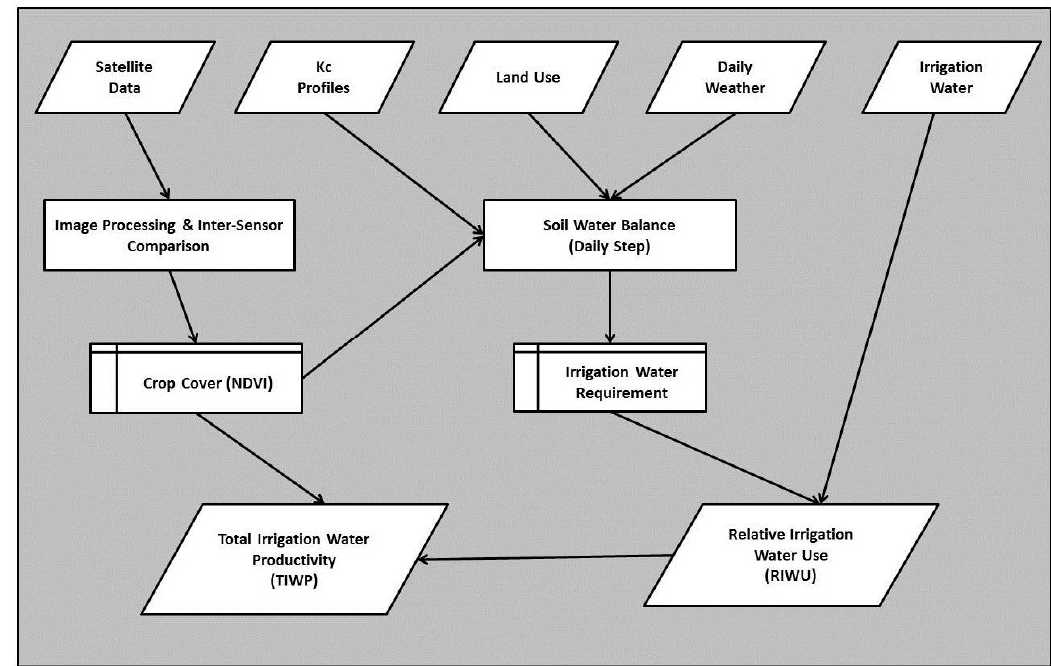
Figure 2. Flowchart showing derivation process of irrigation performance indicators.